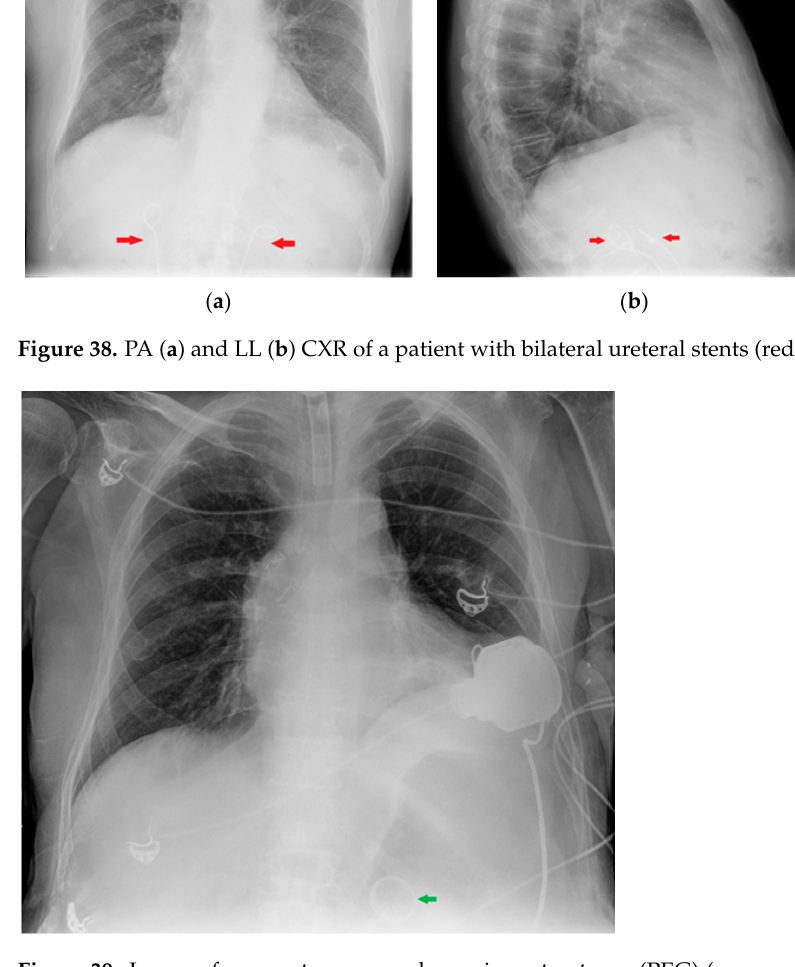
Figure 39. Image of a percutaneous endoscopic gastrostomy (PEG) (green arrow) on CXR. A tracheostomy tube and a LVAD are also present.